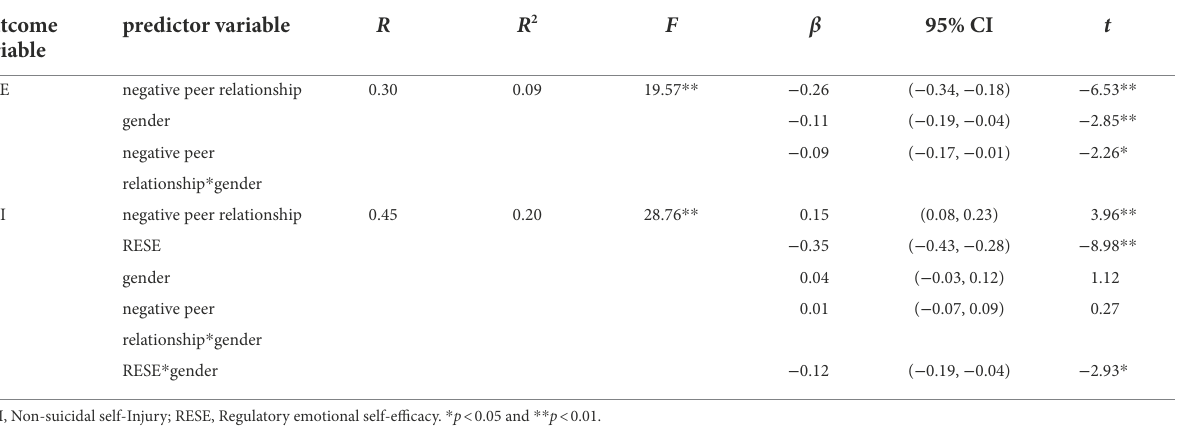
TABLE 3 The moderated-mediating effect of negative peer relationship on NSSI.